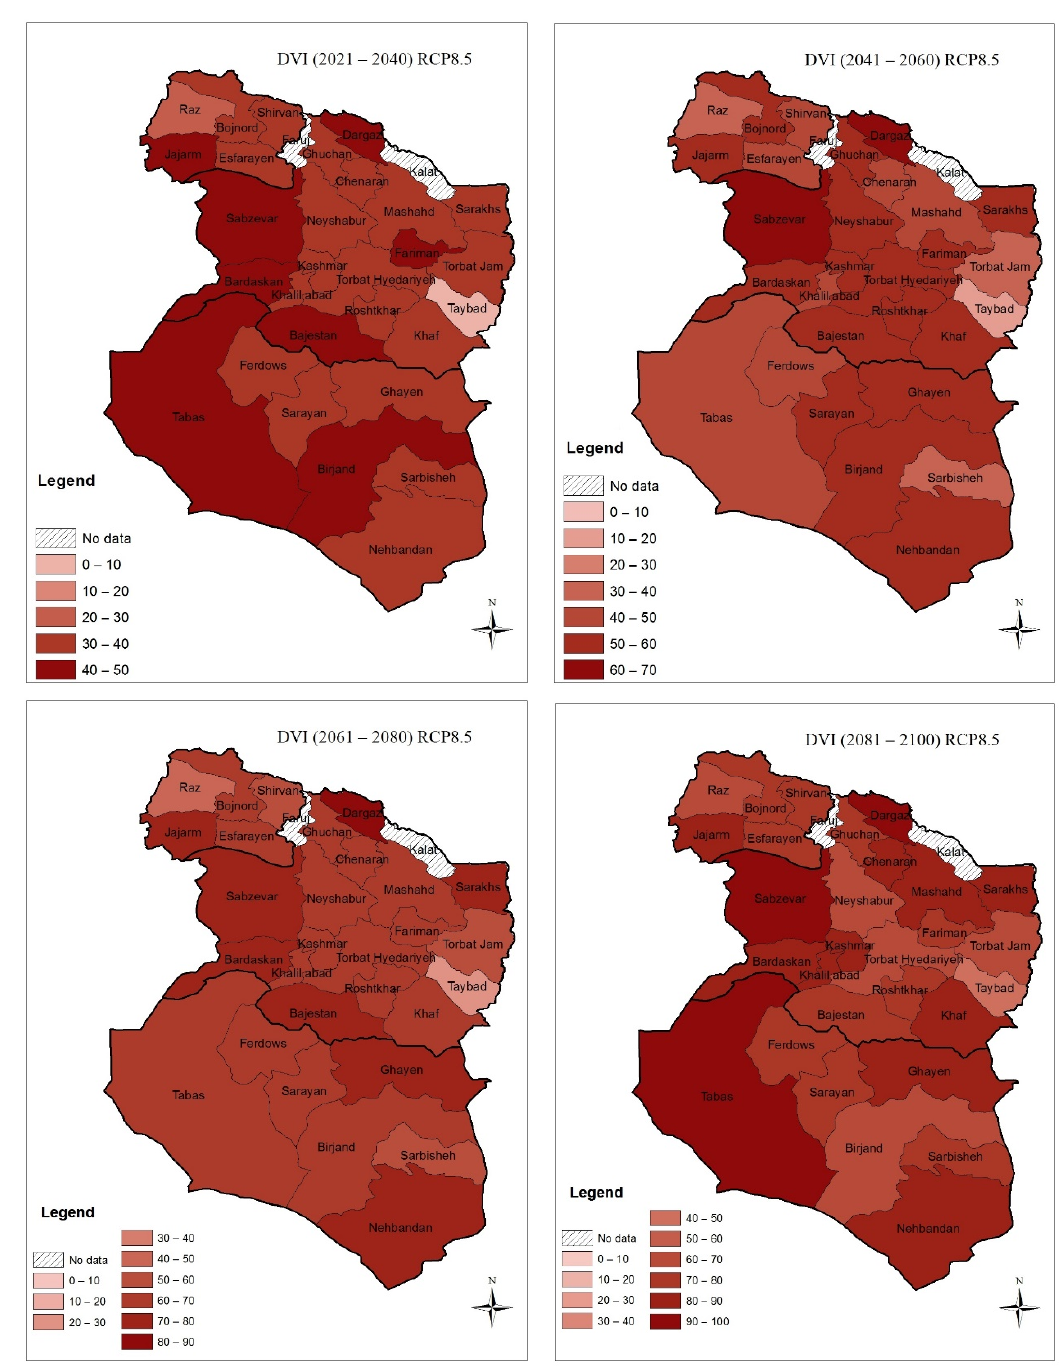
Figure 9. Drought vulnerability index for the 2030s, 2050s, 2070s, and 2090s under RCP8.5 scenarios. Counties with white hachure show lack of data.